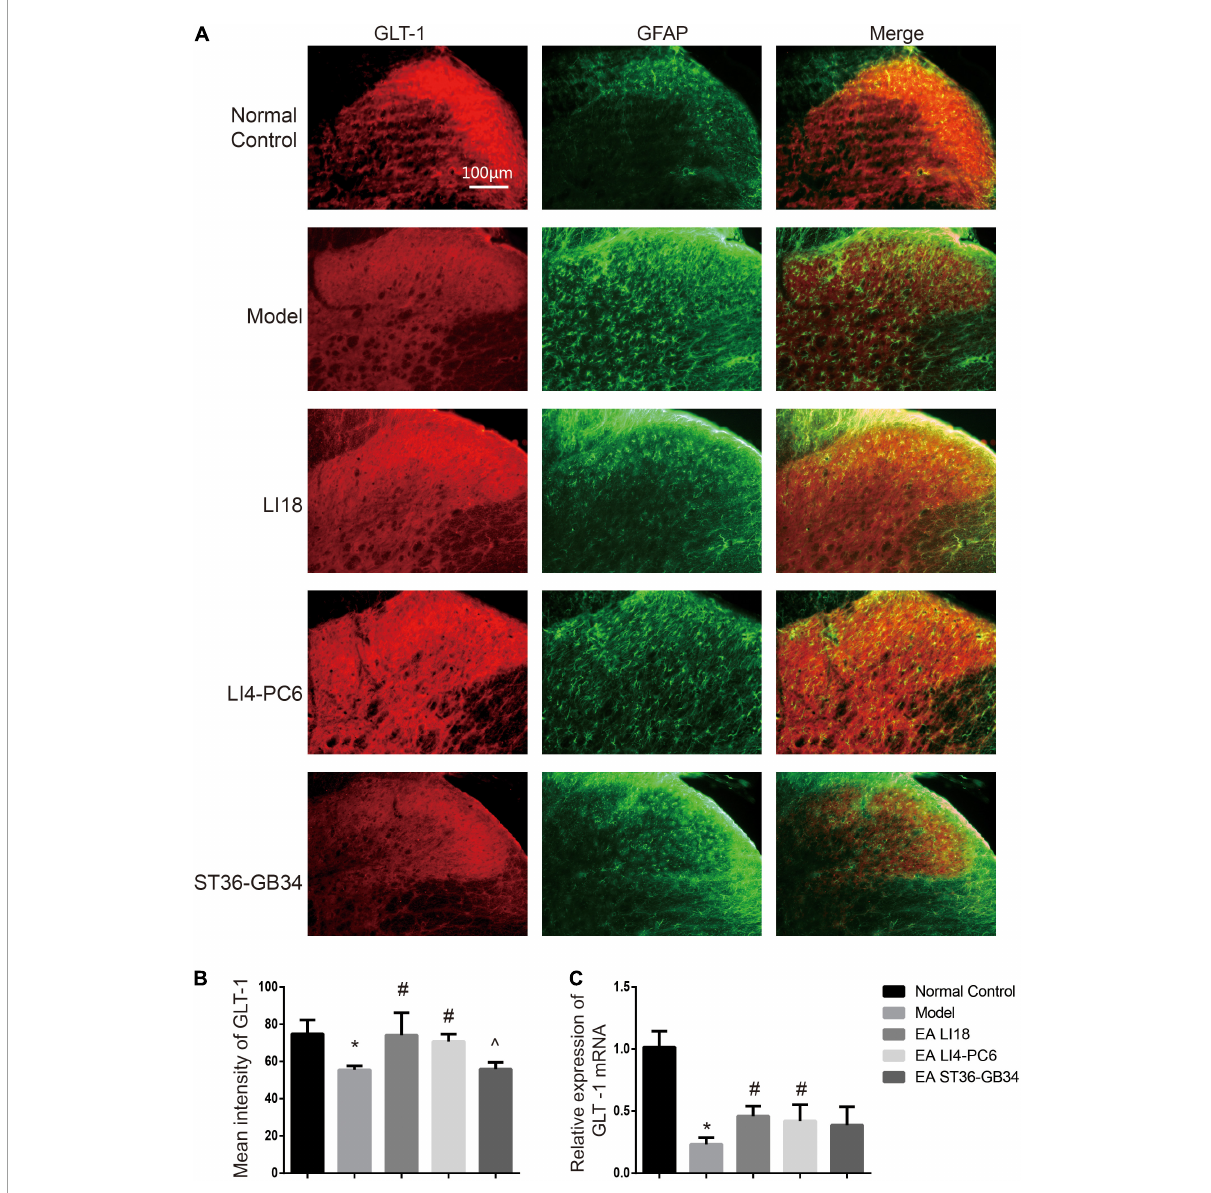
FIGURE8 Comparison of expression of glu transporter-1 (GLT-1) in different groups (mean ± SD, n = 6/group). (A) Fluorescence micrographs of immunohistochemistry staining showing the co-expression (yellow) of GLT-1 (red) and glial fibrillary acidic protein (GFAP) (green) in different groups in the cervical spinal dorsal horns (DHs) 24 h after neck incision. GLT-1 was densely expressed by astrocytes in the normal control group, relatively denser in the EA LI18 and EA LI4-PC6 groups, and lower in both model and EA ST36-GB34 group. The scale bar is 100 µ m. (B) Bar graphs showing the mean fluorescence intensity of GLT-1 in the five groups. GLT-1 expression was reduced in the model group relevant to the control group. After electroacupuncture (EA), the expression levels of GLT-1 were significantly upregulated in both EA LI18 and EA PC6-LI4 groups but not in the EA ST36-GB32 group (vs. the model group). (C) Bar graphs showing the relative expression of GLT-1 mRNA in the five groups. The expression of GLT-1 mRNA was observably decreased in the model group compared to the control group and significantly increased in both EA LI18 and EA PC6-LI4 groups (rather than in the EA ST36-GB34 group) in contrast to the model group. * P < 0.01, vs. the control group, # P < 0.05, vs. the model group, ˆ P < 0.05, vs. the EA LI18 group.